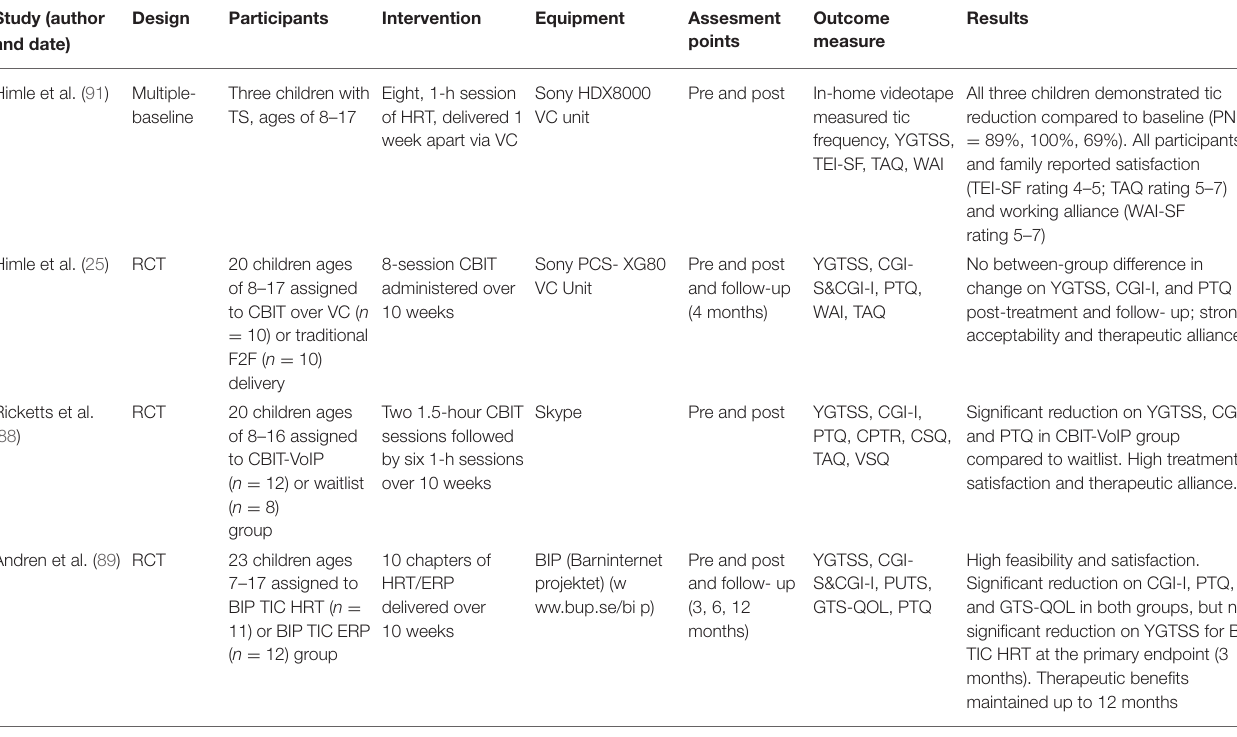
TABLE 1 | Summary of studies for the telemedicine delivered behavior therapy for